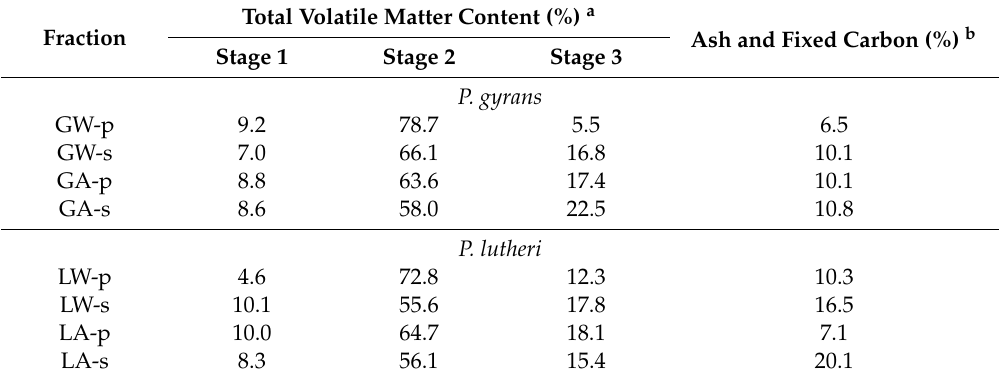
Table 2. Characteristic total volatile matter content (%) of the di ff erent stages for microalgal extracts at a heating rate of 10 ◦ C · min − 1 .